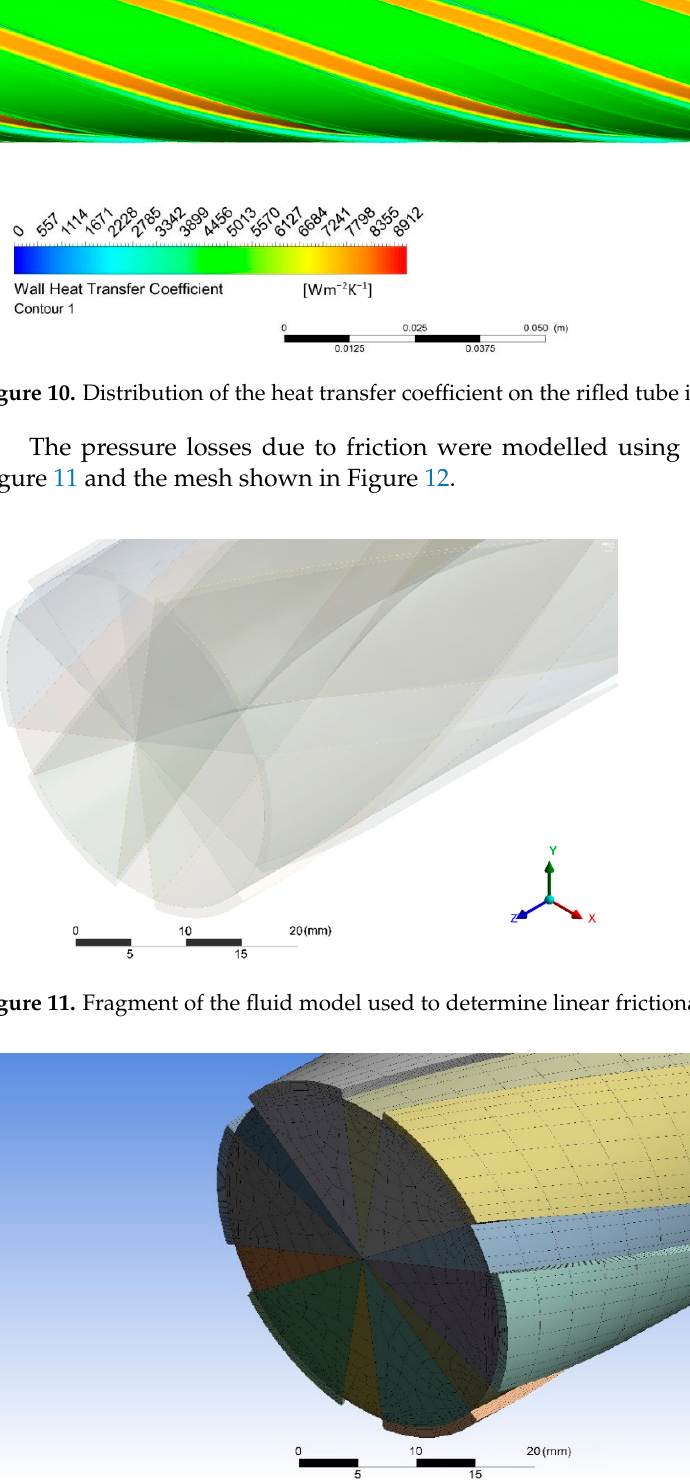
Figure 12. Fragment of the numerical mesh used to calculate frictional pressure losses.